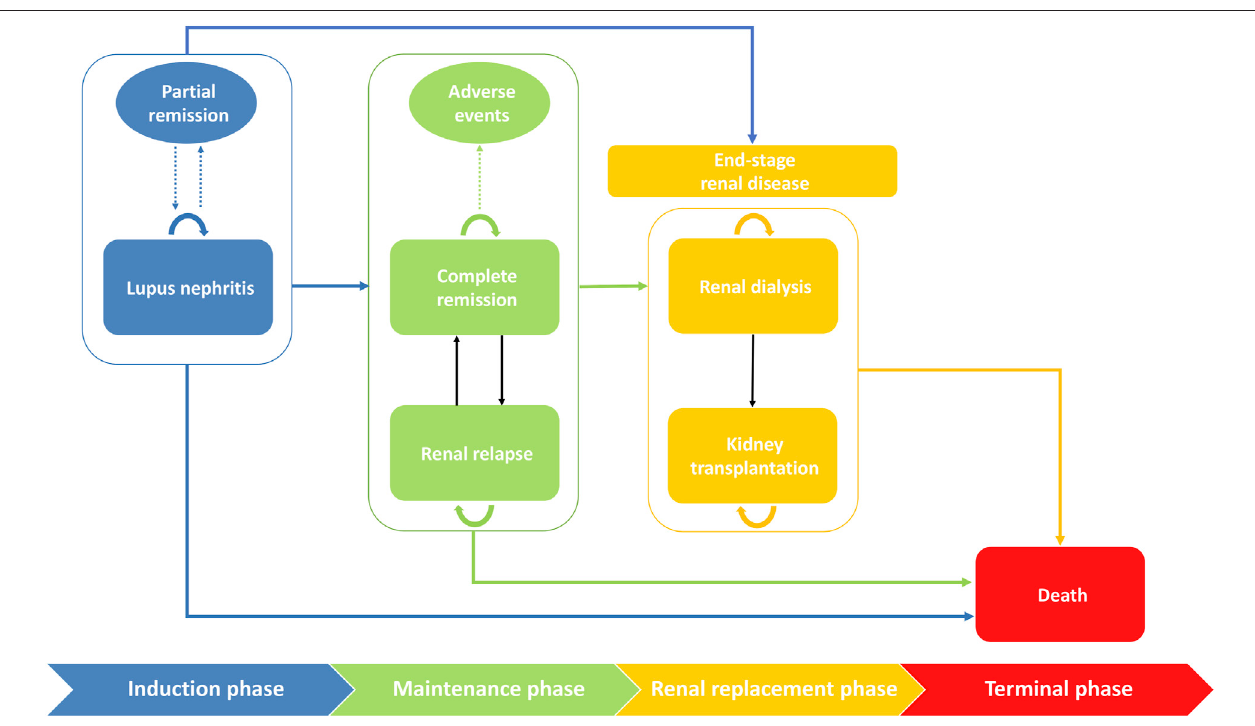
FIGURE1| Markovstructuralmodelofhealthstateswithdiseaseprogressionwith6-monthscycles.Theroundedrectanglesrepresenthealthstatesandtheovals represent the potential outcomes in each phase. Transitions between phases or between states were indicated by solid arrows. The dotted arrows indicated potential outcomes. The initial phase is induction phase where patients start to receive therapy. After achieving complete remission, patients will progress to the maintenance therapy. Patients in both induction and maintenance phase may transit to renal replacement phase. All health states have a risk of death.